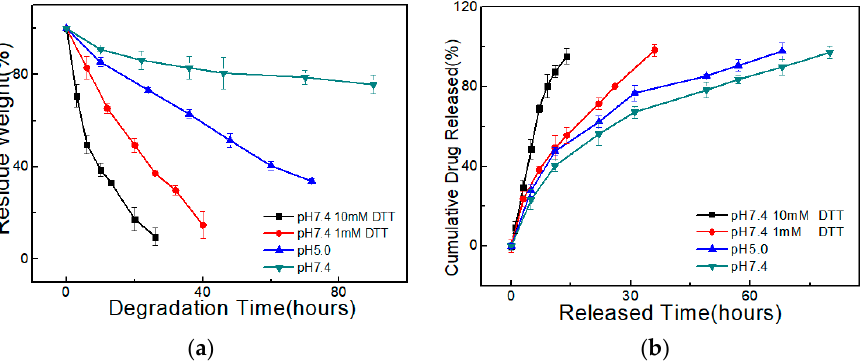
Figure 8. ( a ) Degradation and ( b ) release of a model drug (rhodamine B) by the hydrogels.